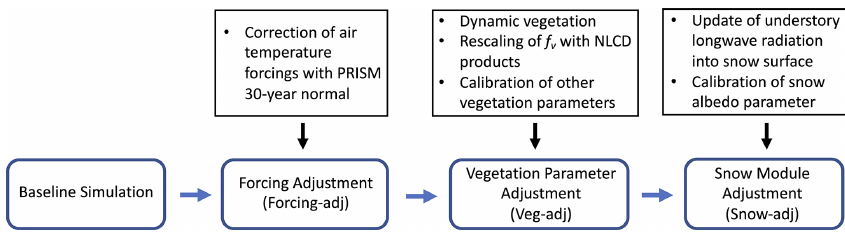
Figure 3. Flowchart of the stepwise calibration